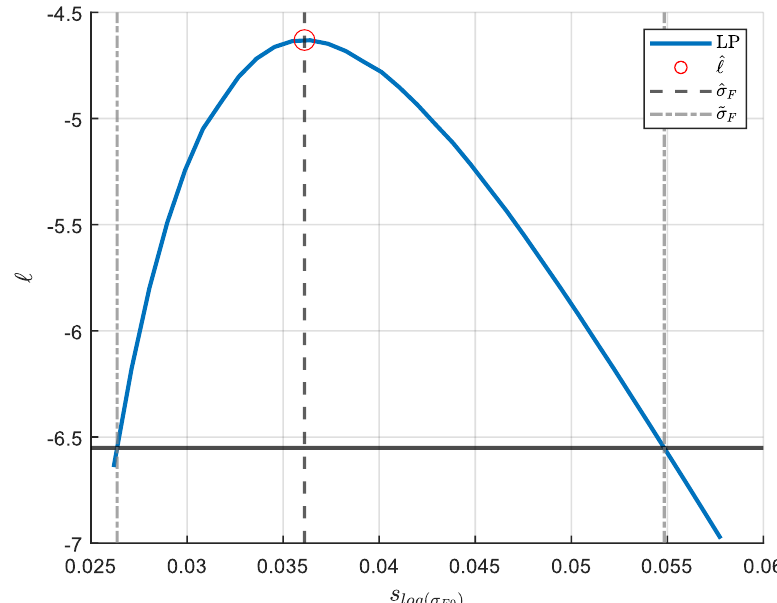
Figure A1. Example of LP and LR for s log ( σ Figure B1. Example of LP and LR for